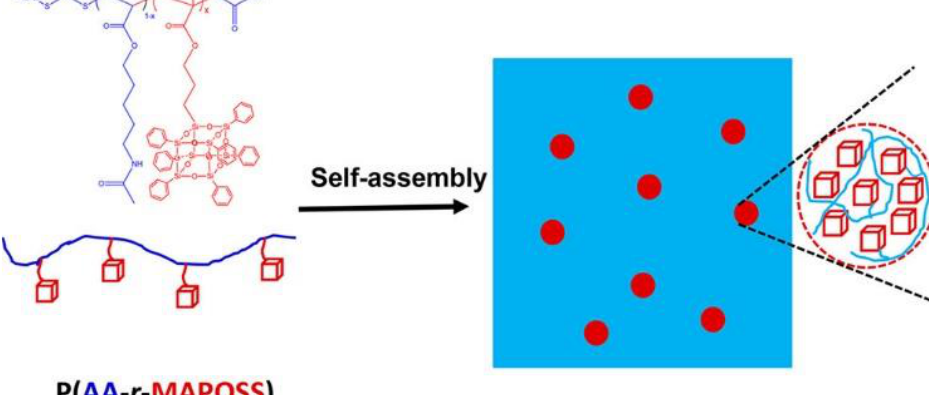
Figure 1. Phase separation on self-assembly of POSS covalently grafted to polymer chains. Reprinted with permission from ACS Appl. Polym. Mater. 2019, 1 , 359–368 [50]. Copyright (2019) American Chemical Society.